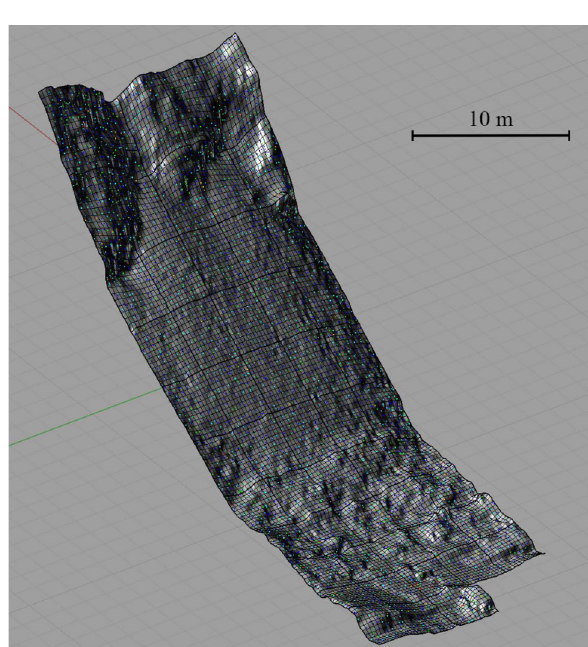
Fig. 13 BF NURBS surface covered by disturbed point cloud (deviation between data sets is shown by colors: blue—group (1), light blue—group (2), green—group (3), orange—group (4), red— group (5)